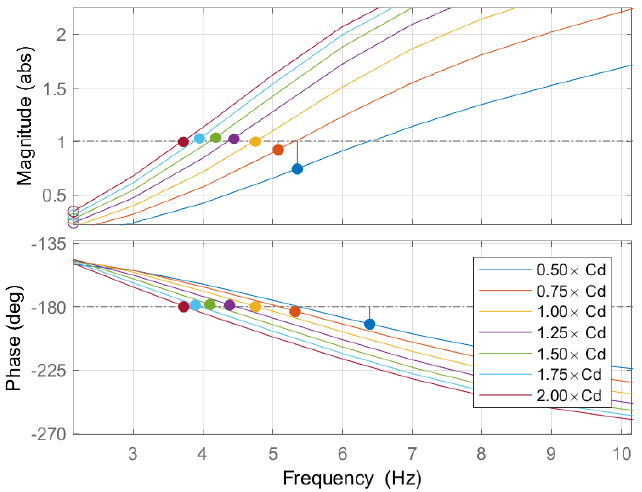
Figure 18. Bode diagram of the system eigenvalue λ 1 . Variation of DC-link